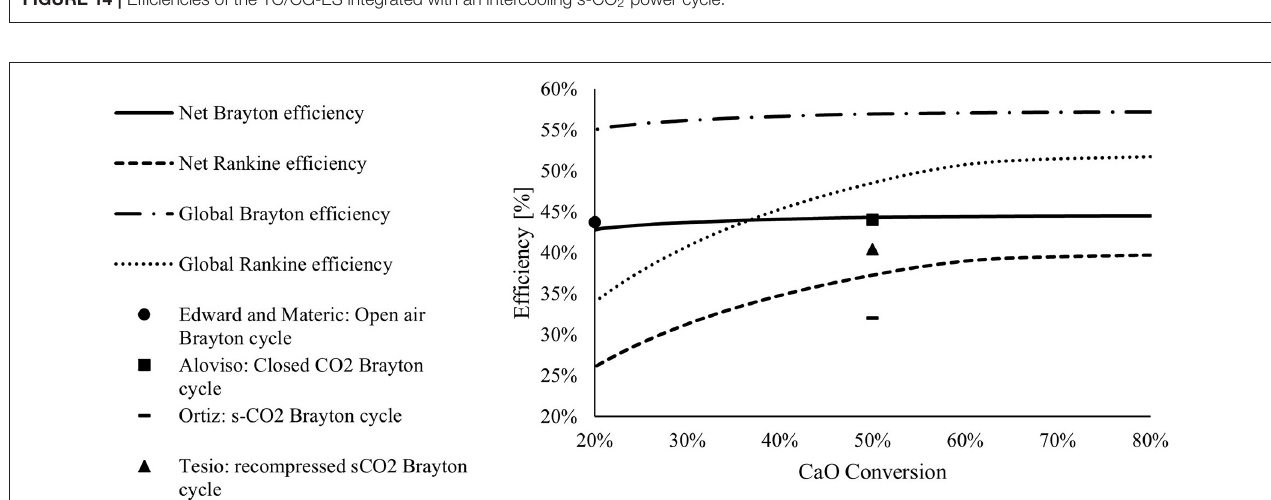
FIGURE 15 | Comparison of the integrated solar CaL system at different material performances.